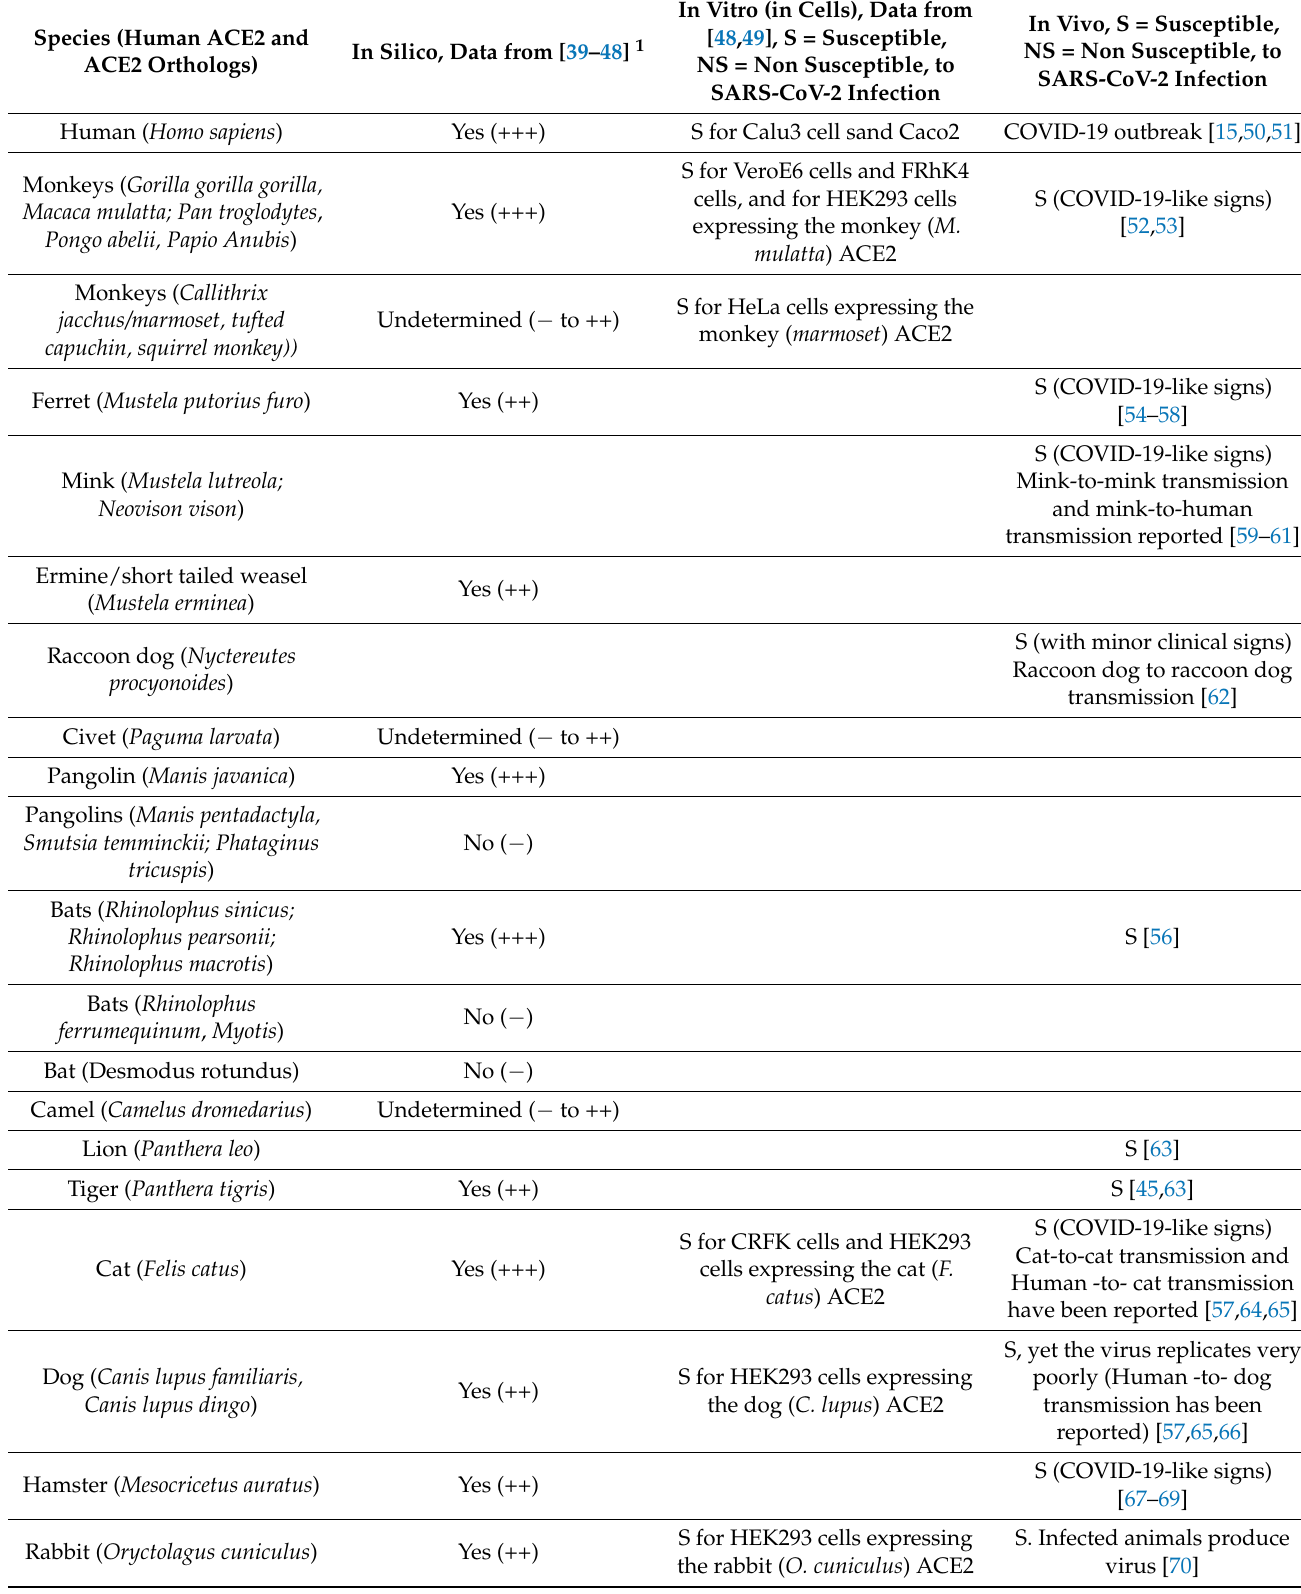
Table 1. Angiotensin-converting enzyme 2 (ACE2) ability to be recognized by SARS-CoV-2 (Wuhan Hu1 strain/G clade).